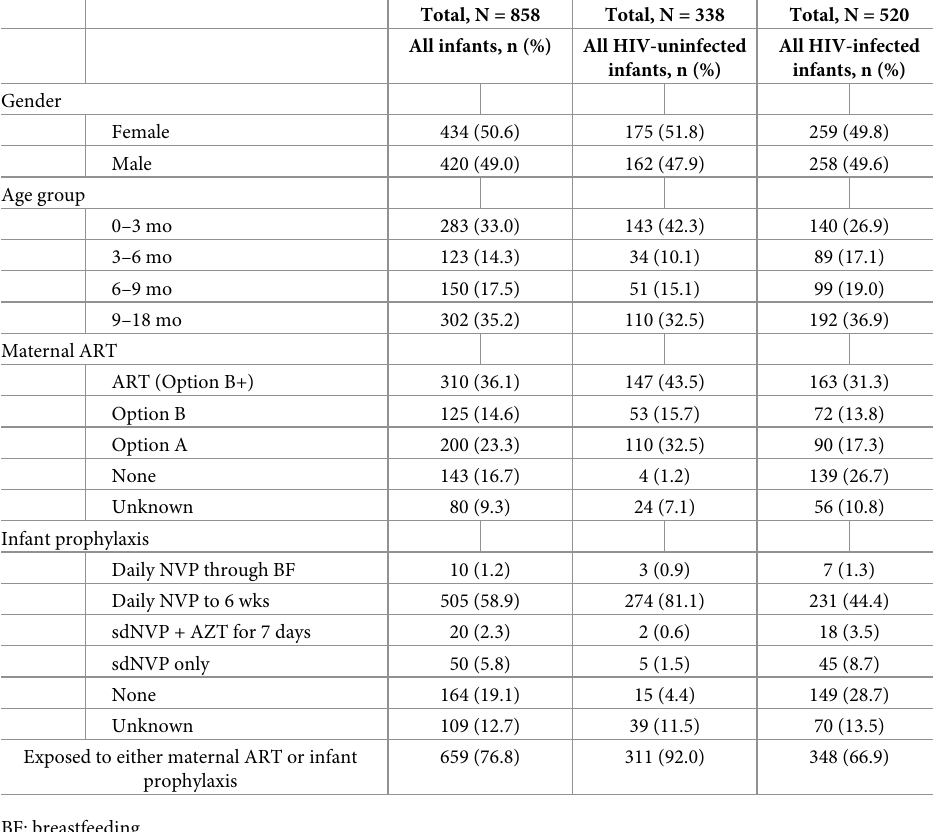
Table 1. Demographic characteristics of study